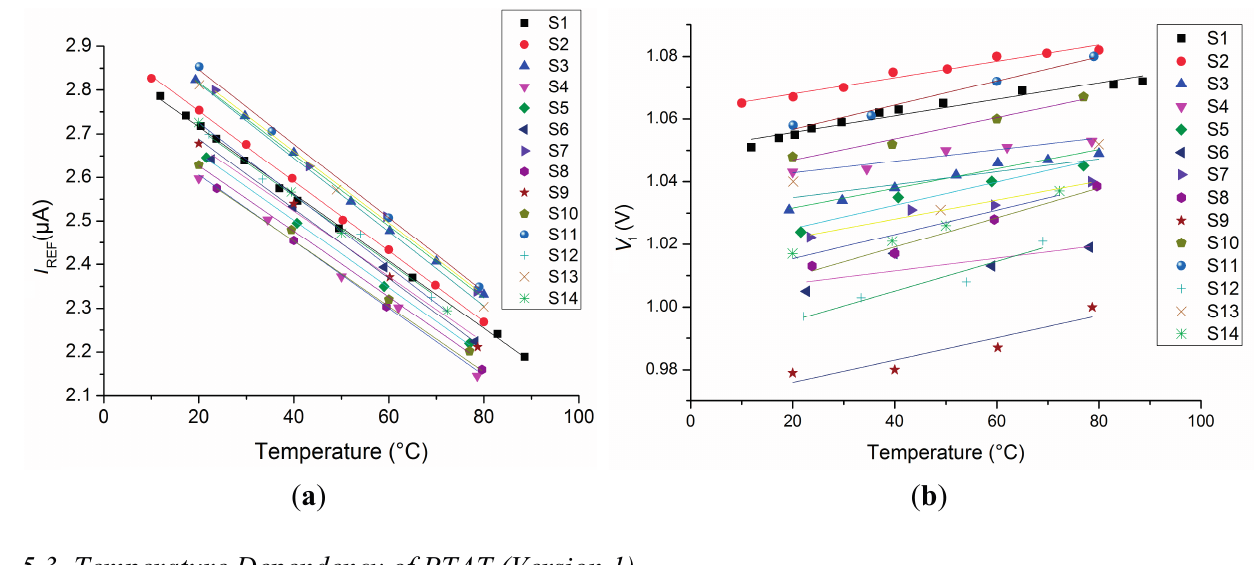
Figure 9. ( a ) Measured reference currents with temperature; ( b ) Measured temperature dependency of all reference voltages V 1